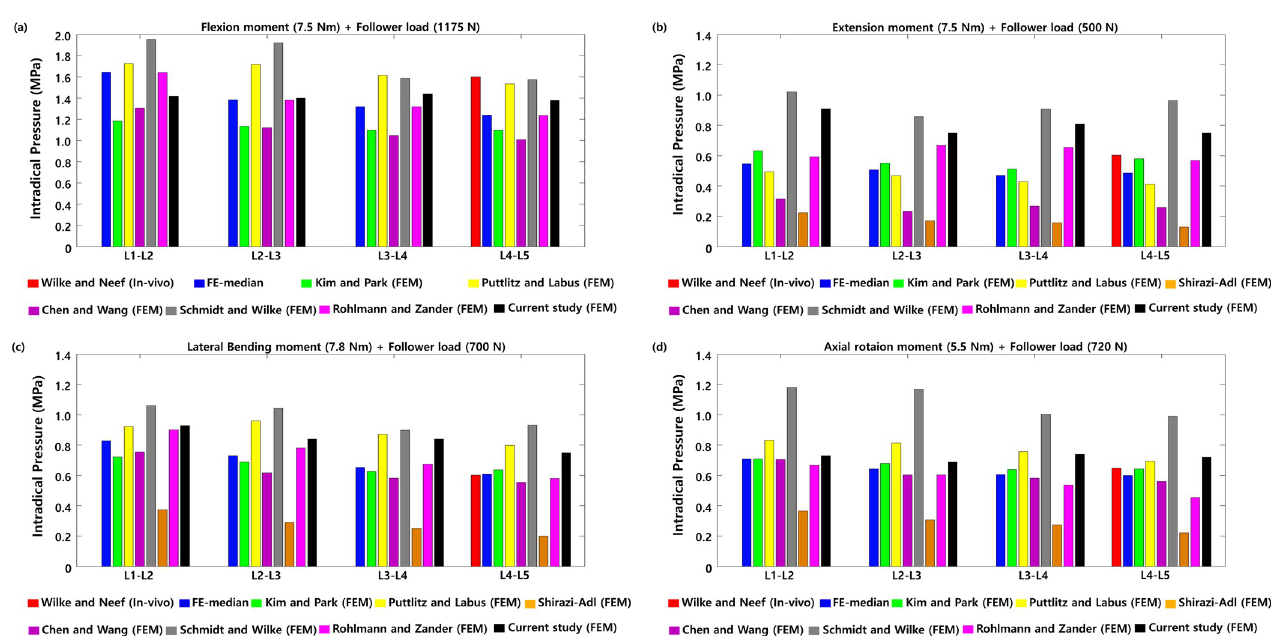
Fig 5. Nucleus pulposus pressure of the L4-L5 intervertebral disc measured under a (a) flexion moment (7.5 N � m) and follower load (1175 N), (b) extension moment (7.5 N � m) and follower load (500 N), (c) lateral bending moment (7.8 N � m) and follower load (700 N), and (d) axial rotation moment (5.5 N � m) and follower load (720 N) (The red bar is the median value of previous in vivo experimental findings, and other bars represent previous and current findings obtained from finite element analyses).